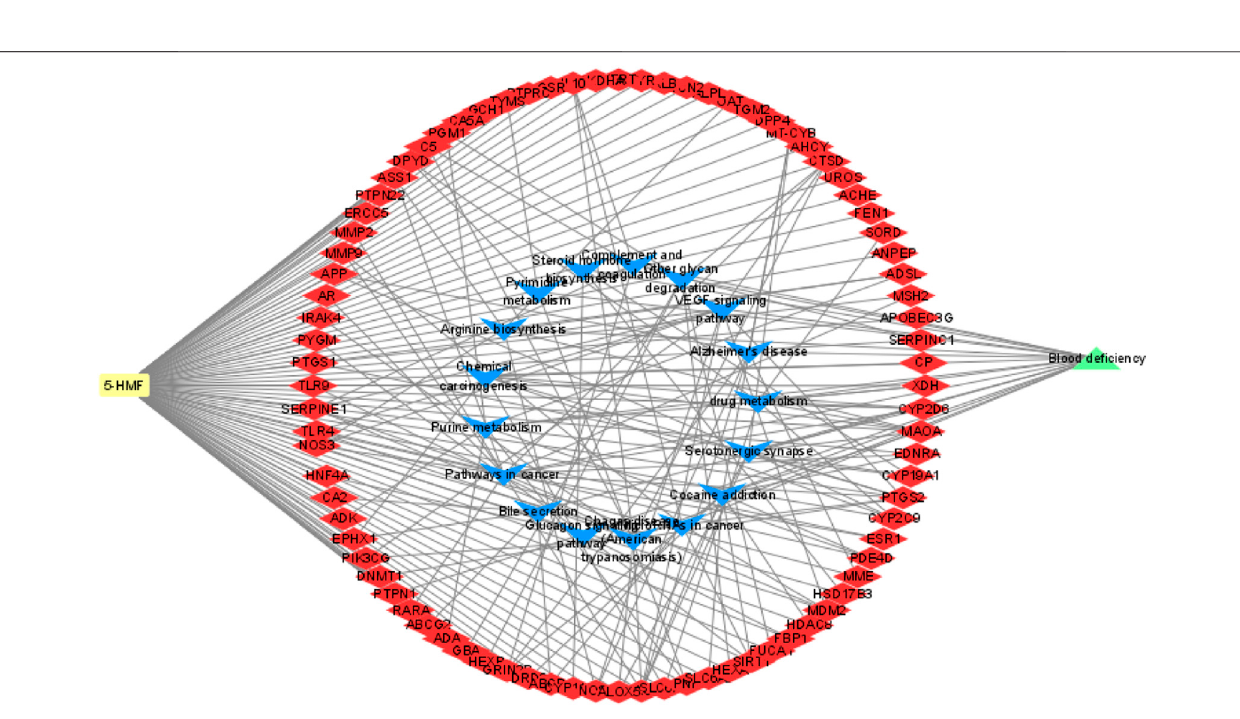
Frontiers in Pharmacology |